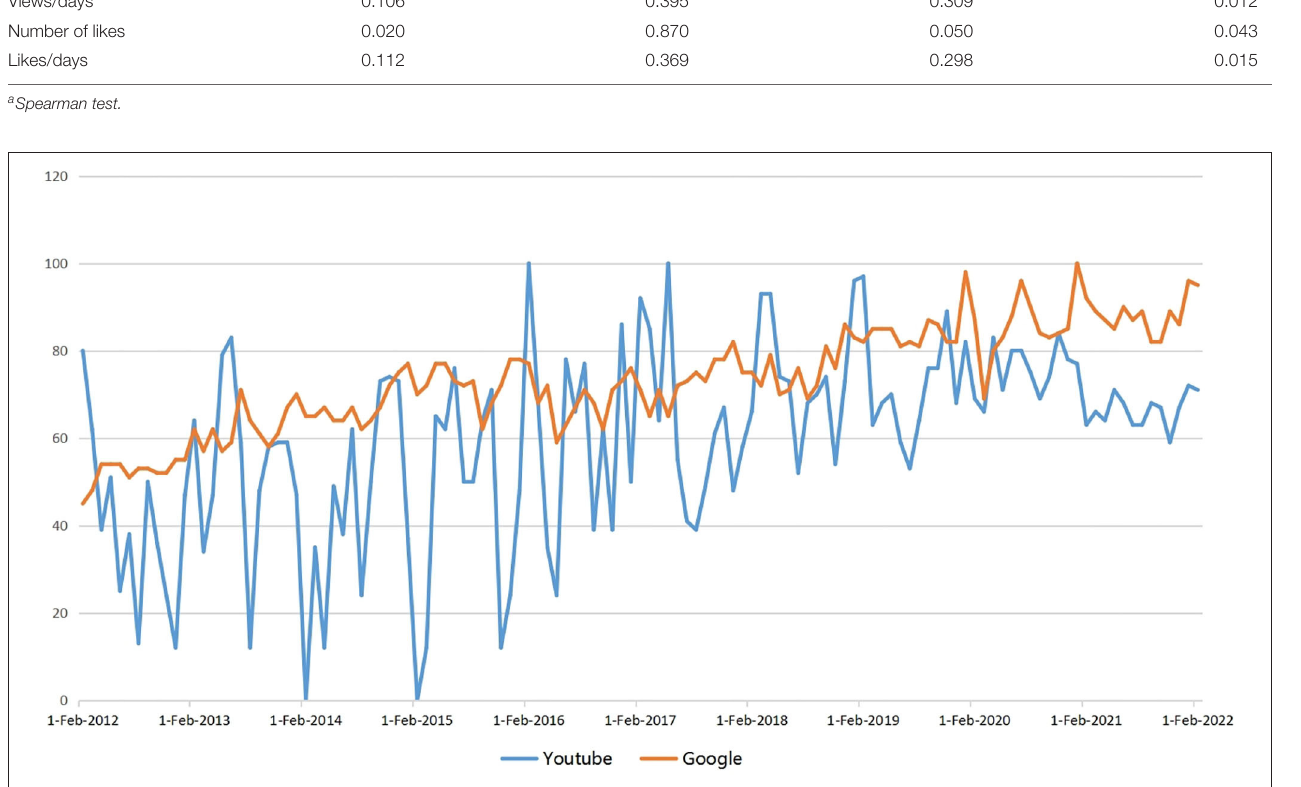
platform prompts more people to use it to disseminate and acquire health information